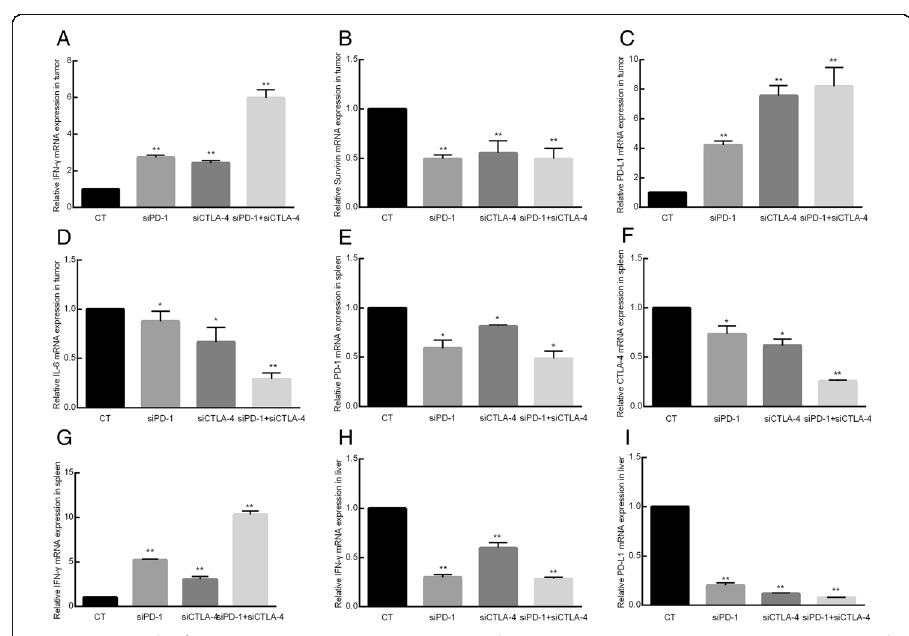
Fig. 3 PCR results for PD-1 , PD-L1 , CTLA-4 , IFN- γ , IL-6 and Survivin mRNA in various tissues. CT = control, siPD-1 = group injected with siRNA for PD-1, siCTLA-4 = group injected with siRNA for CTLA-4, siPD-1 + siCTLA-4 = group injected with siRNA for PD-1 + CTLA-4. a – Level of IFN- γ mRNA in the tumors.